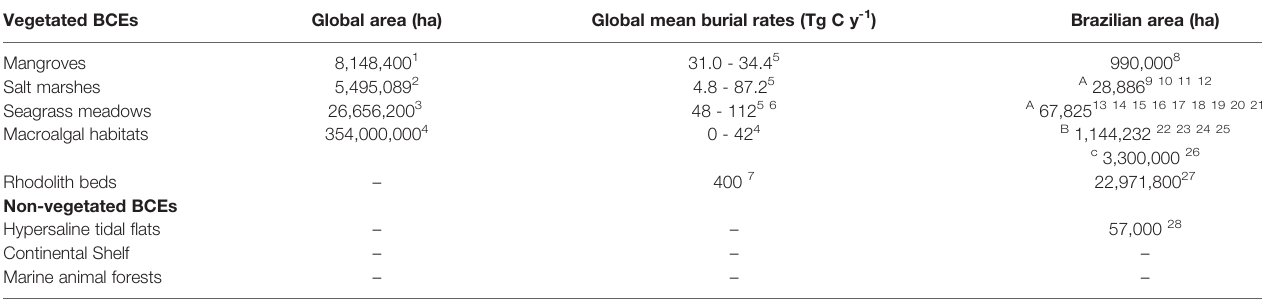
TABLE 1 | Dimensions and carbon burial rates of established and potential BCEs. Estimates for global area, global mean burial rate, and Brazilian ecosystem areas. Vegetated BCEs